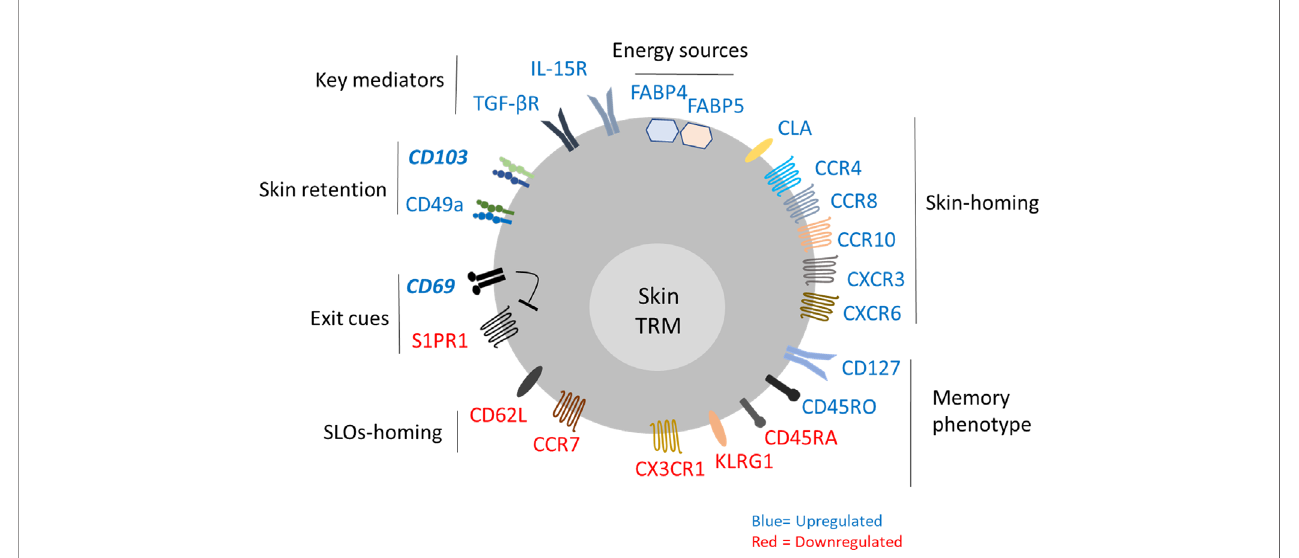
FIGURE 1 | Characterization of skin resident memory T